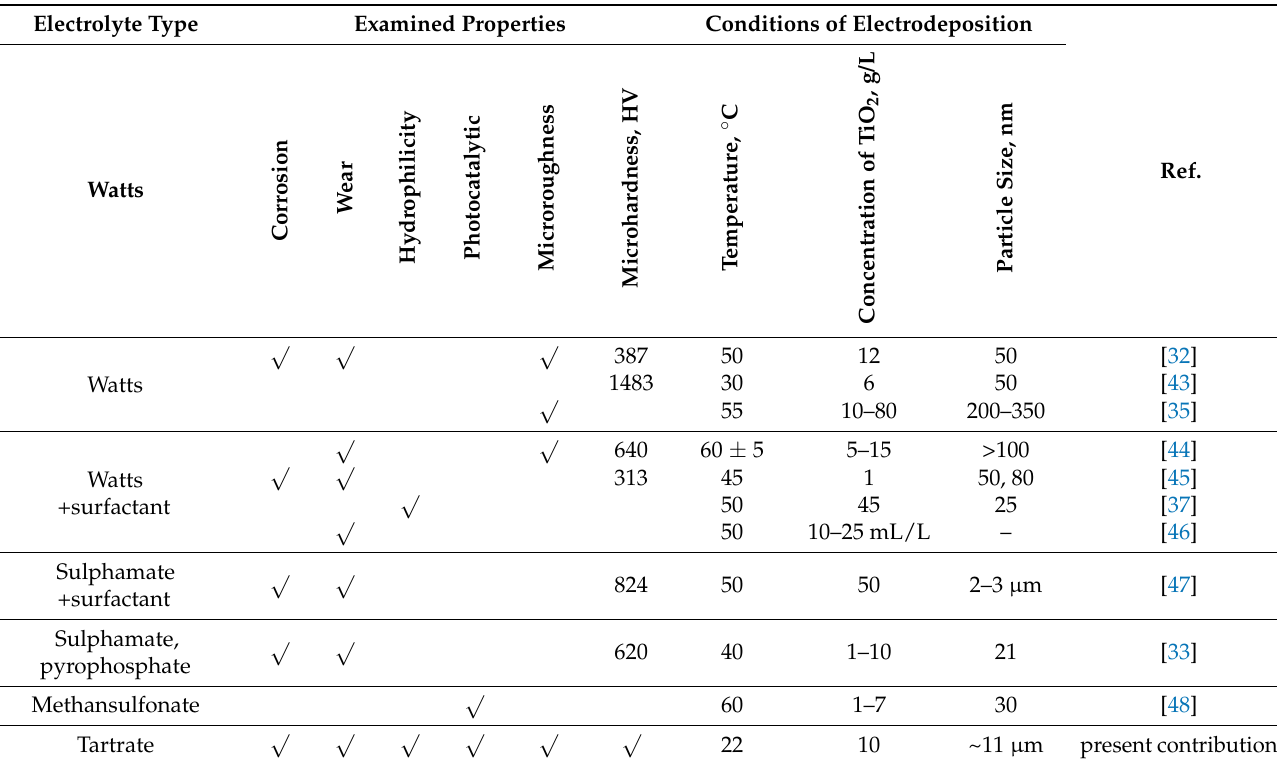
Table 1. Influence of TiO 2 particles on properties of nickel